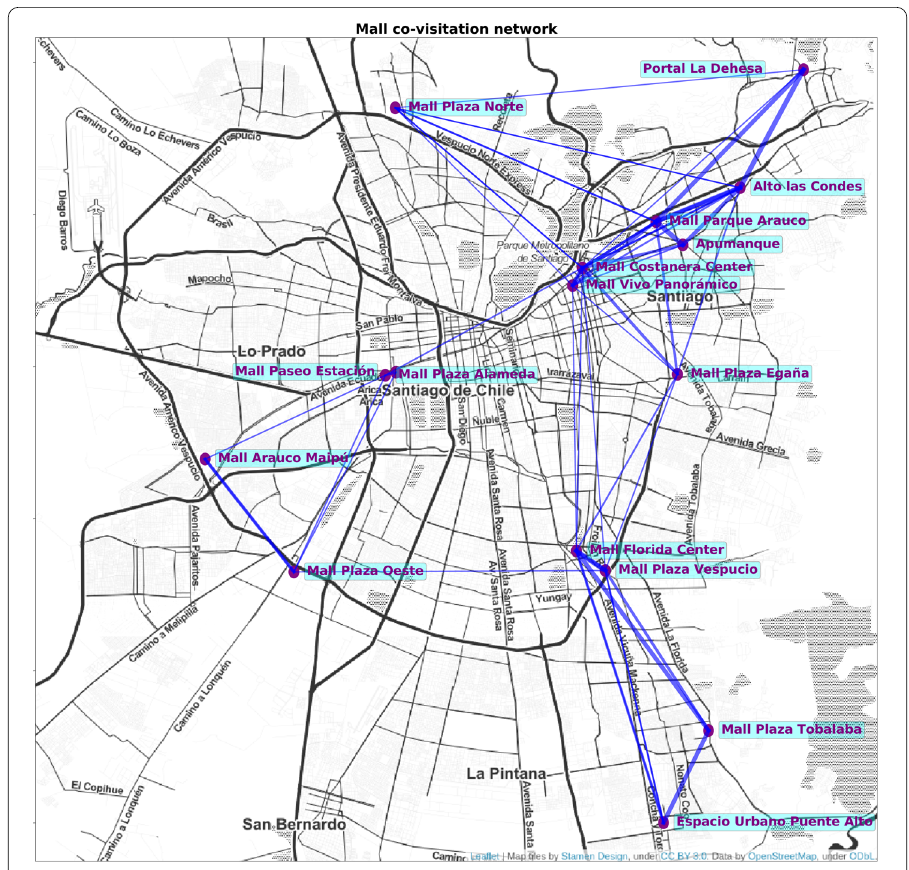
Figure 10 Malls network representing the conditional probabilities of visiting one mall during the month, given the fact that another mall is also visited. A minimum threshold of p = 0.10 has been